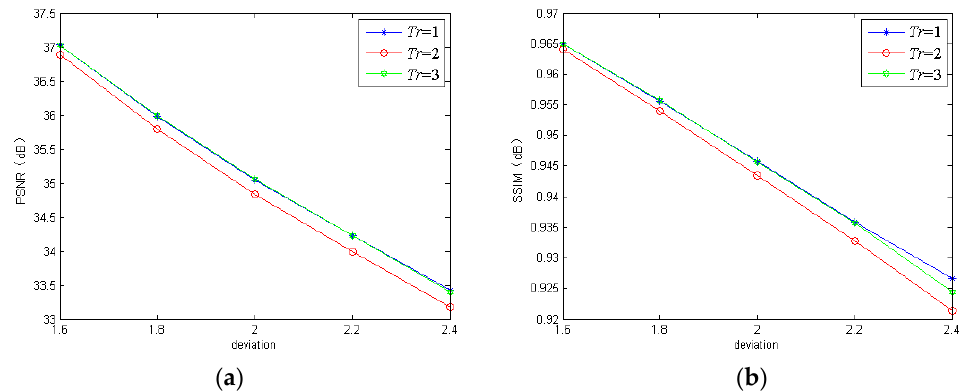
Figure 6. The PSNR and SSIM of the proposed model using different iterative times on the REDS dataset: ( a ) PSNR; ( b ) SSIM.